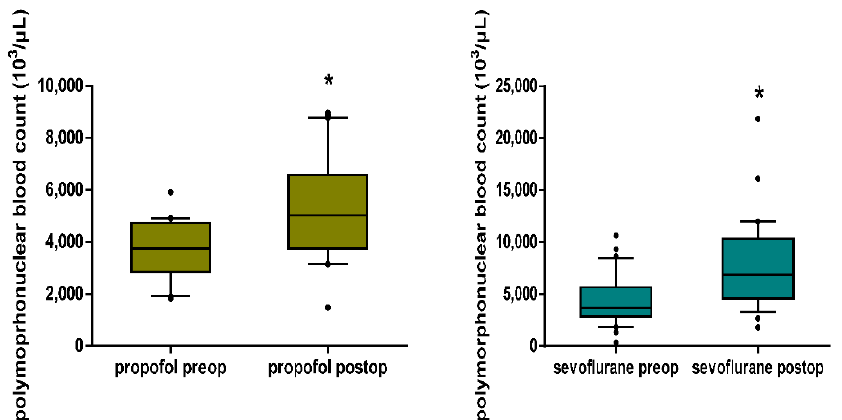
Figure 4. Box plots of polymorphonuclear blood count in peripheral blood in the propofol and sevoflurane group, preoperatively and postoperatively. Both propofol and sevoflurane maintenance caused a significant increase in the polymorphonuclear blood count ( p < 0.001, respectively). The box plots depict the median and the interquartile range, and the whiskers depict the 10th and 90th percentiles; * p < 0.05 in comparison to the preoperative status. Table 2. Standardized values for serial variables and comparisons between the two groups. * signifi- cant difference between